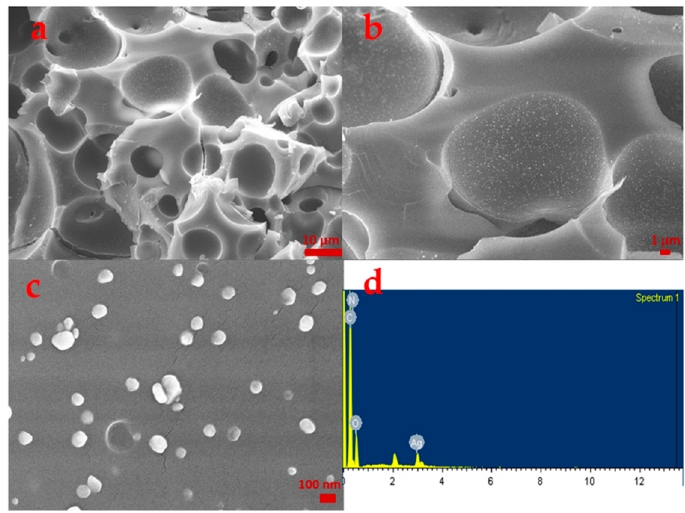
Figure 7. FE-SEM micrographs of the AgNPs in the network (sample B) at three different magnifications (10 µ m ( a ), 1 µ m ( b ), 100 nm ( c )) and EDX spectrum ( d